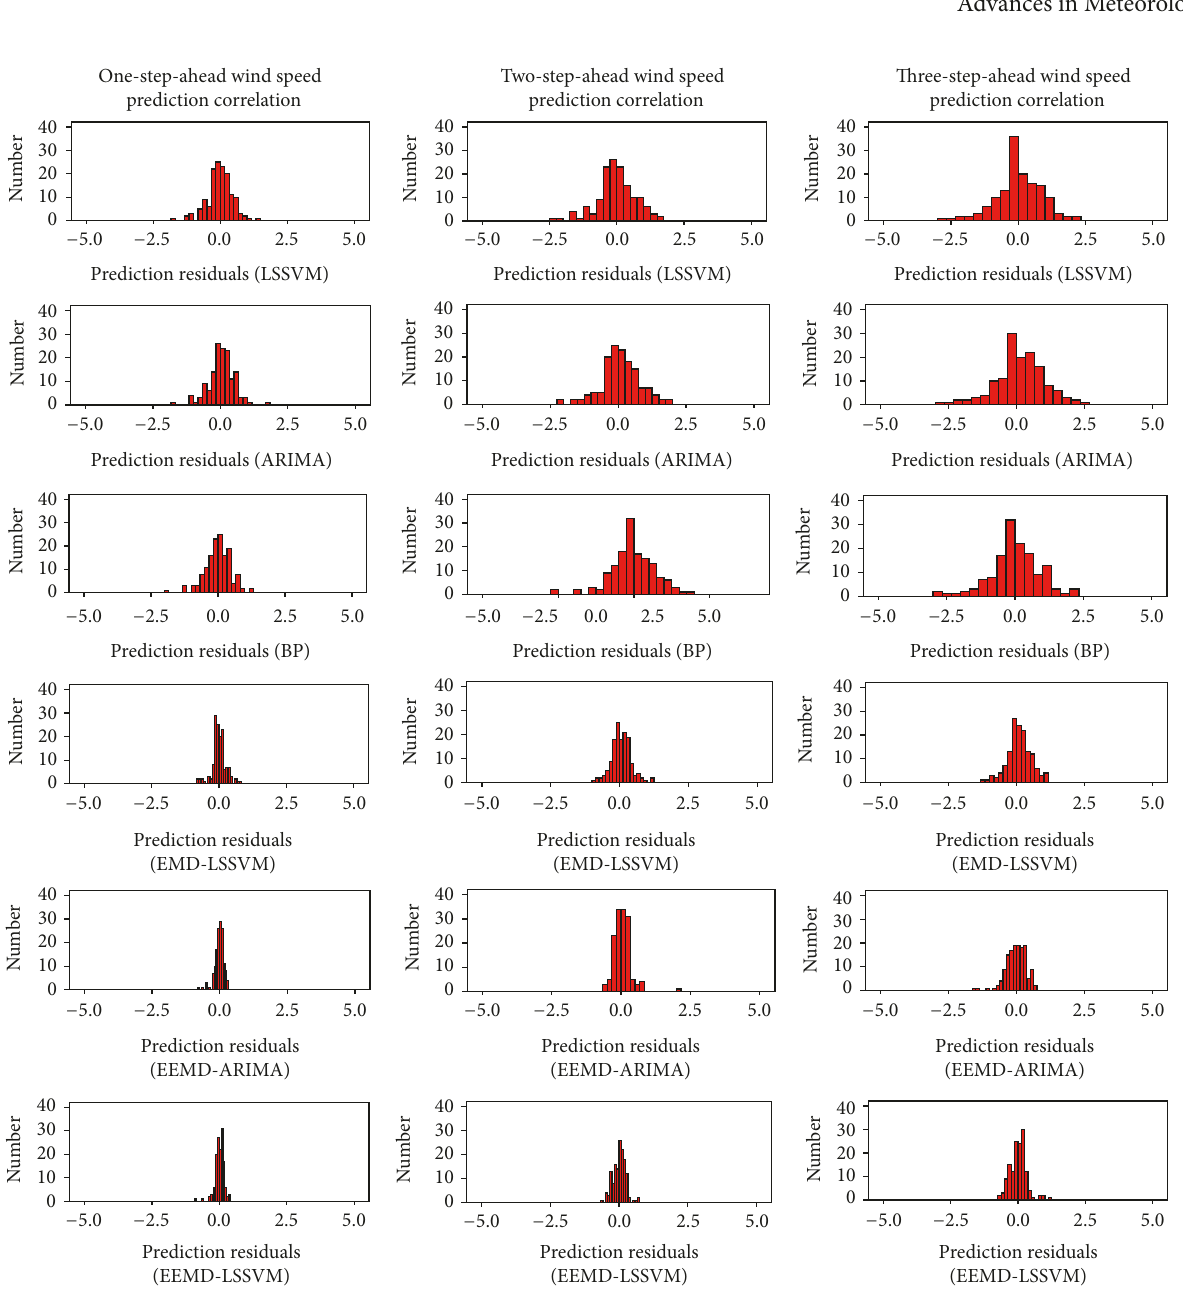
Figure 15: Histograms of prediction residuals for different models (Case